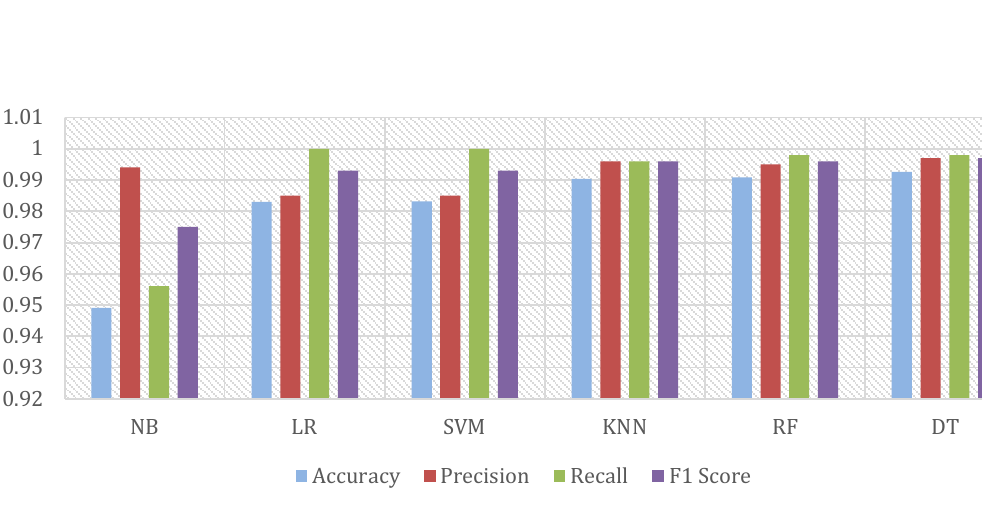
Figure 5. Accuracy, precision, recall and F1 score for full